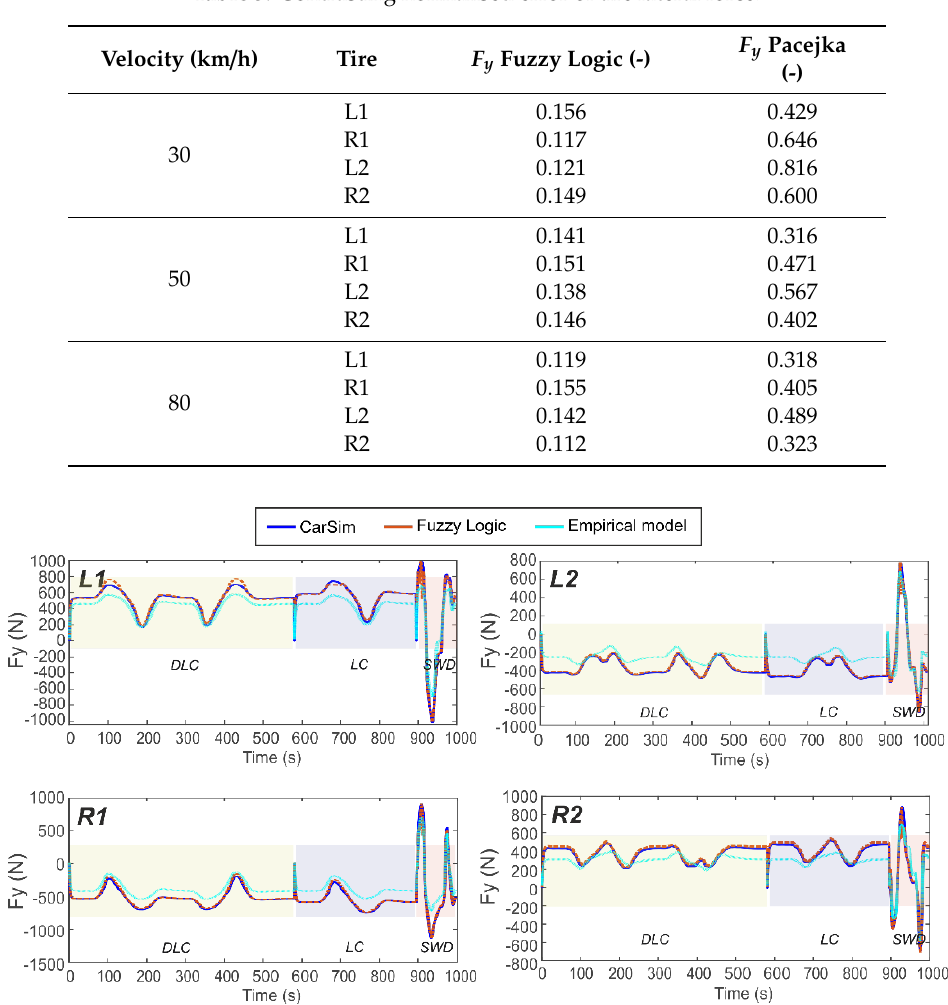
Figure 13. Experimental lateral force fitted surface based on Pacejka model at 30 km / h. Table 3. Contrasting normalised error of tire lateral force.